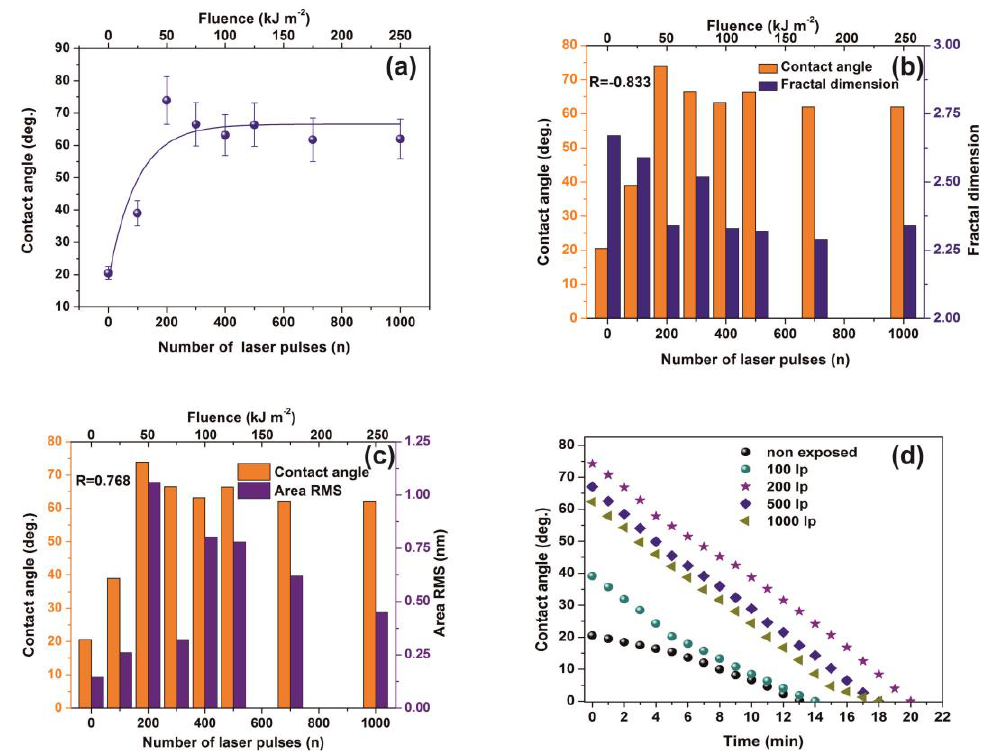
Figure 8. Water contact angle (CA) vs. the number of laser pulses: ( a ) Water CA vs. the number of laser pulses. ( b ) column chart diagram of CA and fractal dimensionality vs. laser fluence. The mean correlation factor is − 0.833; ( c ) column chart diagram of CA and area RMS of PAM vs. laser fluence. The mean correlation factor is 0.768 pointing to a strong correlation between fractal dimensionality, CA, and area RMS over a wide range of laser fluence; ( d ) column chart diagram of water CA at di ff erent time intervals. The almost similar slopes point to a uniform surface response at di ff erent VUV photon fluence. From Figures 4a, 5a,b, 7a,b and 8a the surface chemical modification is saturated at ~500 laser pulses, because of the low penetrating depth of the 157 nm laser photons, indicating the strong correlation between fractal dimensionality, CA, area RMS, Young’s modulus and surface